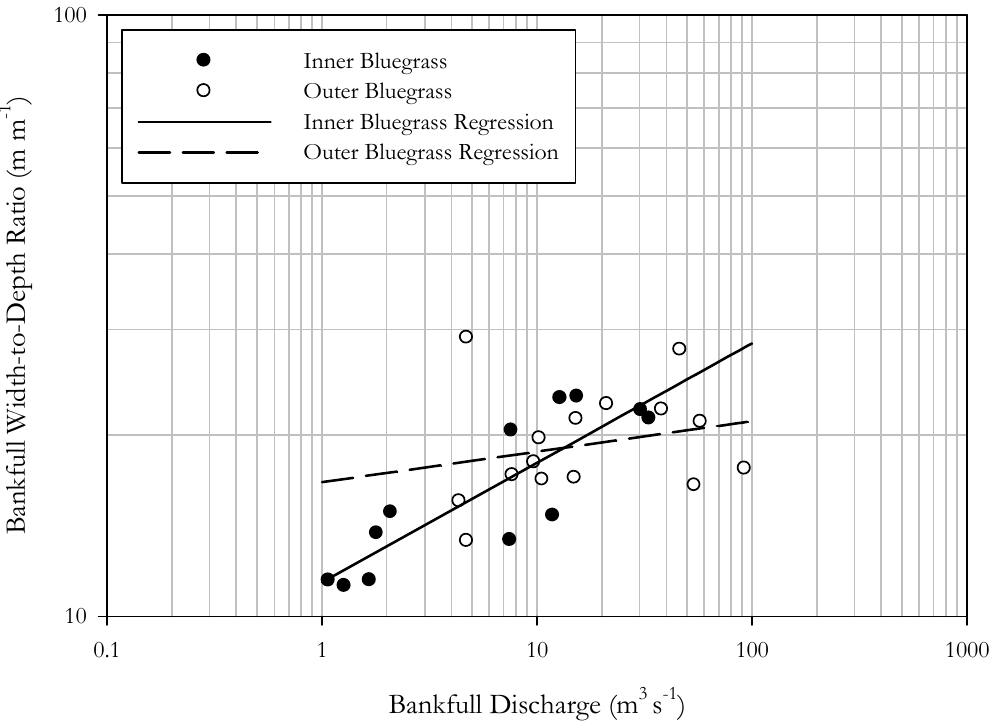
Figure 7. Bankfull width-to-depth ratio vs . bankfull discharge for the Inner Bluegrass and Outer Bluegrass regions.